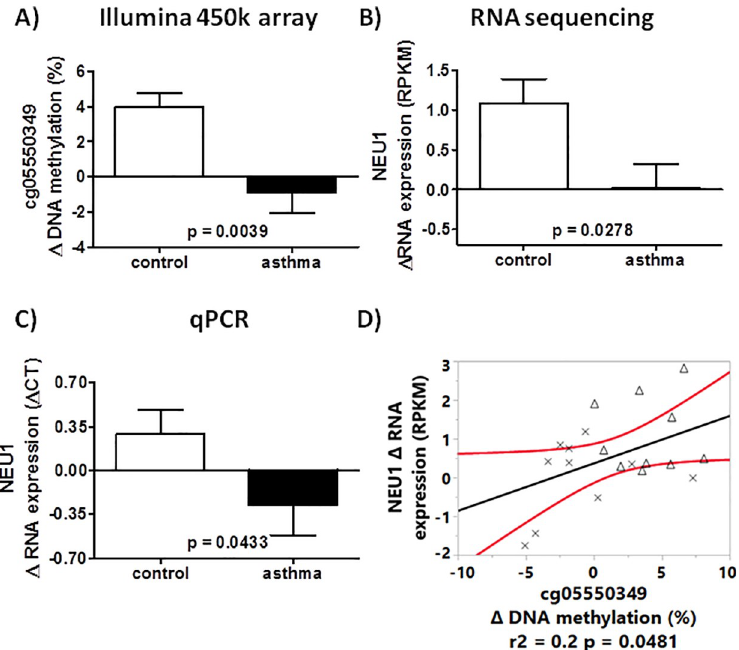
Fig 7. RIDM (cg05550349) and RIRE of NEU1 for asthmatics and controls. RIDM were detected with a HumanMethylation450 BeadChip Kit (A) and RIRE was detected by mRNA sequencing (B) and qPCR (C). The correlation between change in DNA methylation in cg05550349 with change in mRNA expression of NEU1 (D). Crosses represent children with asthma and the triangles represent controls.